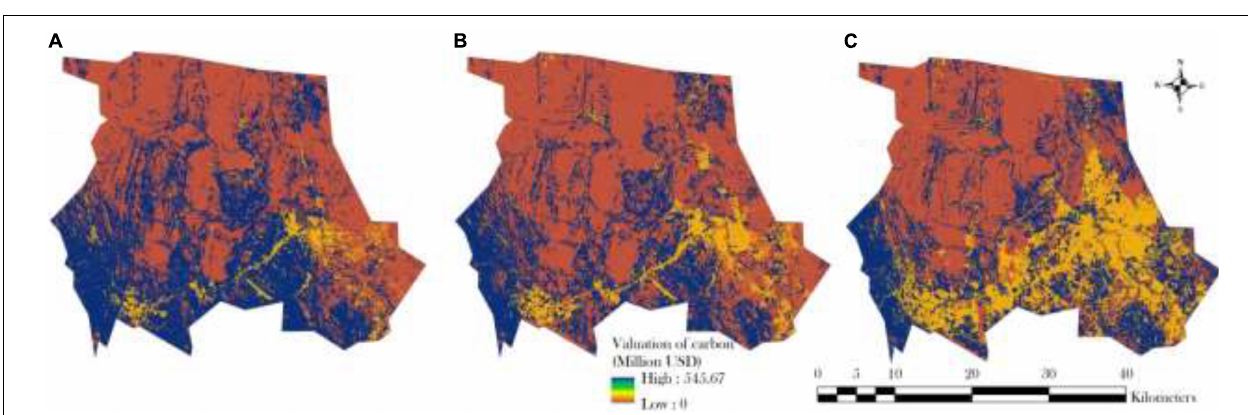
FIGURE 7 | Valuation of carbon storage modeling with InVest software for (A) 1990, (B) 2000, and (C)